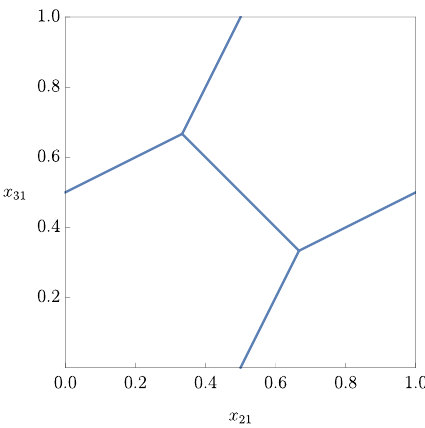
Figure 8. The space of non-standard N = 3 solutions in the high-temperature limit with identical chemical potentials ~(cid:1) a = 1 = 3. Here we only show the real components x 21 and x 31 under the decomposition u ij = x ij + y ij (cid:28) . The parameter space is actually one-complex dimensional, which would be apparent if we had not suppressed the y 21 - y 31